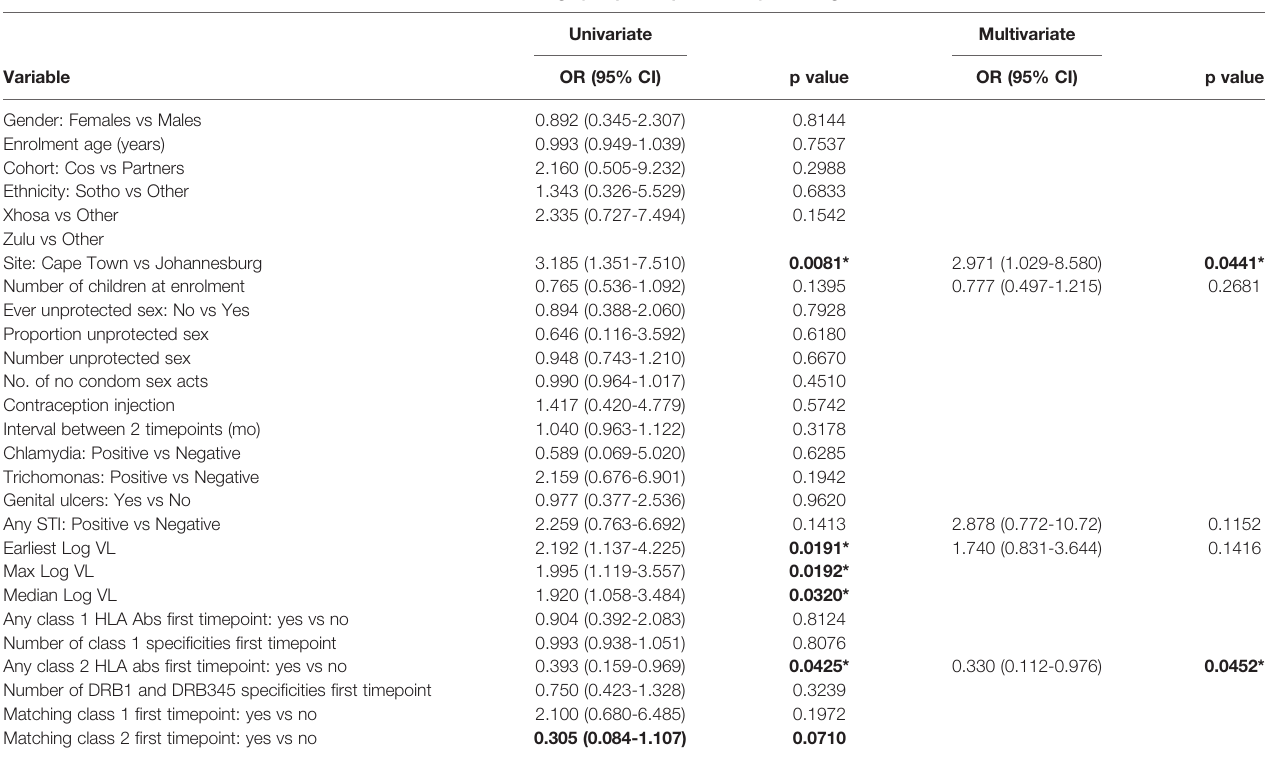
TABLE 6 | Risk factors for HIV acquisition by individuals who were HIV-uninfected at enrolment, by univariate and multivariate regression (n=115 highly exposed persistently seronegative controls and 28 HIV-seroconverters). HIV-seroconverters versus highly exposed persistently seronegative controls